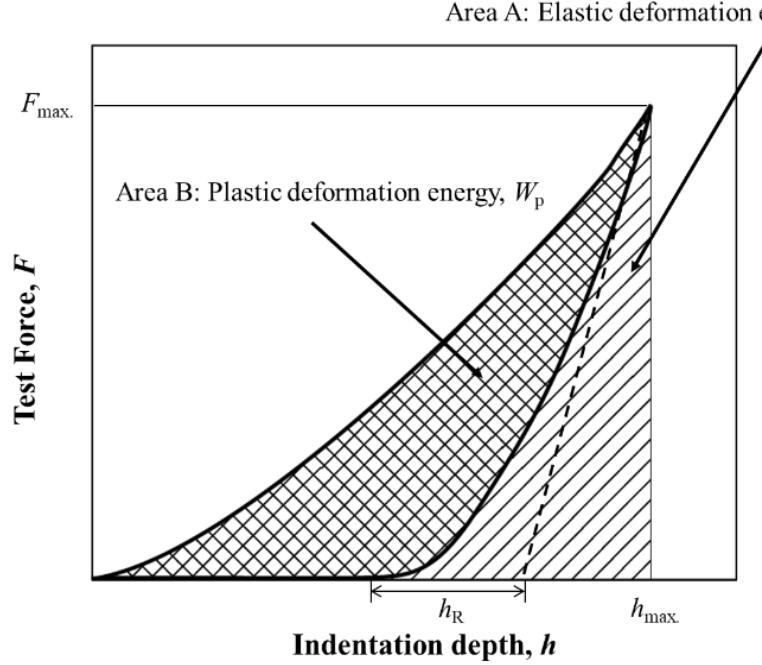
Figure 1. Definition of the elastic and plastic work energies based on load – displacement curves.